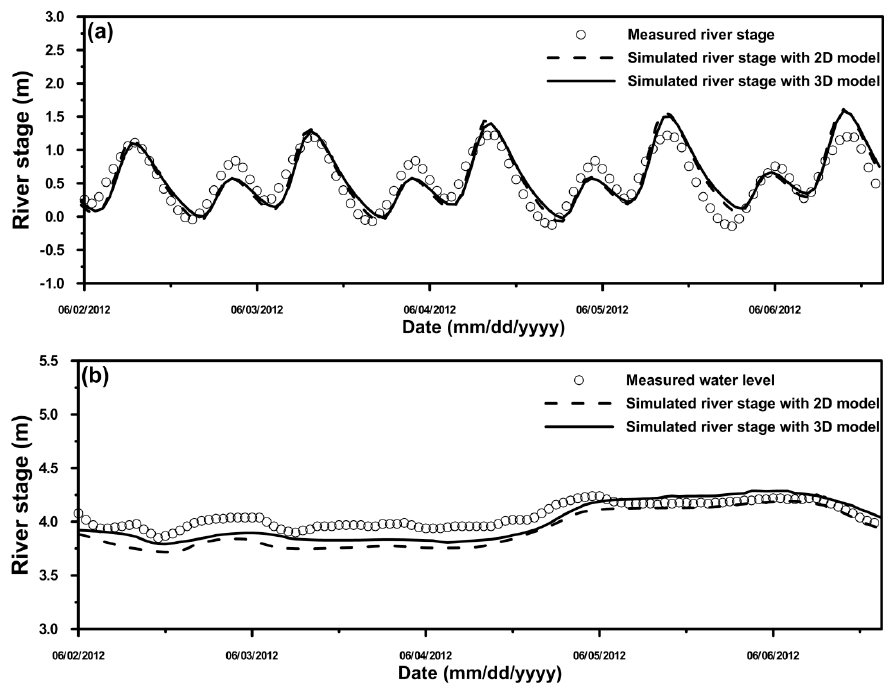
Figure 13. Comparison of the simulated river stages using the 2D and 3D models with the resampled cross-section data under the low flow condition at: ( a ) Mashan Bridge; and ( b ) Xinzhong station.